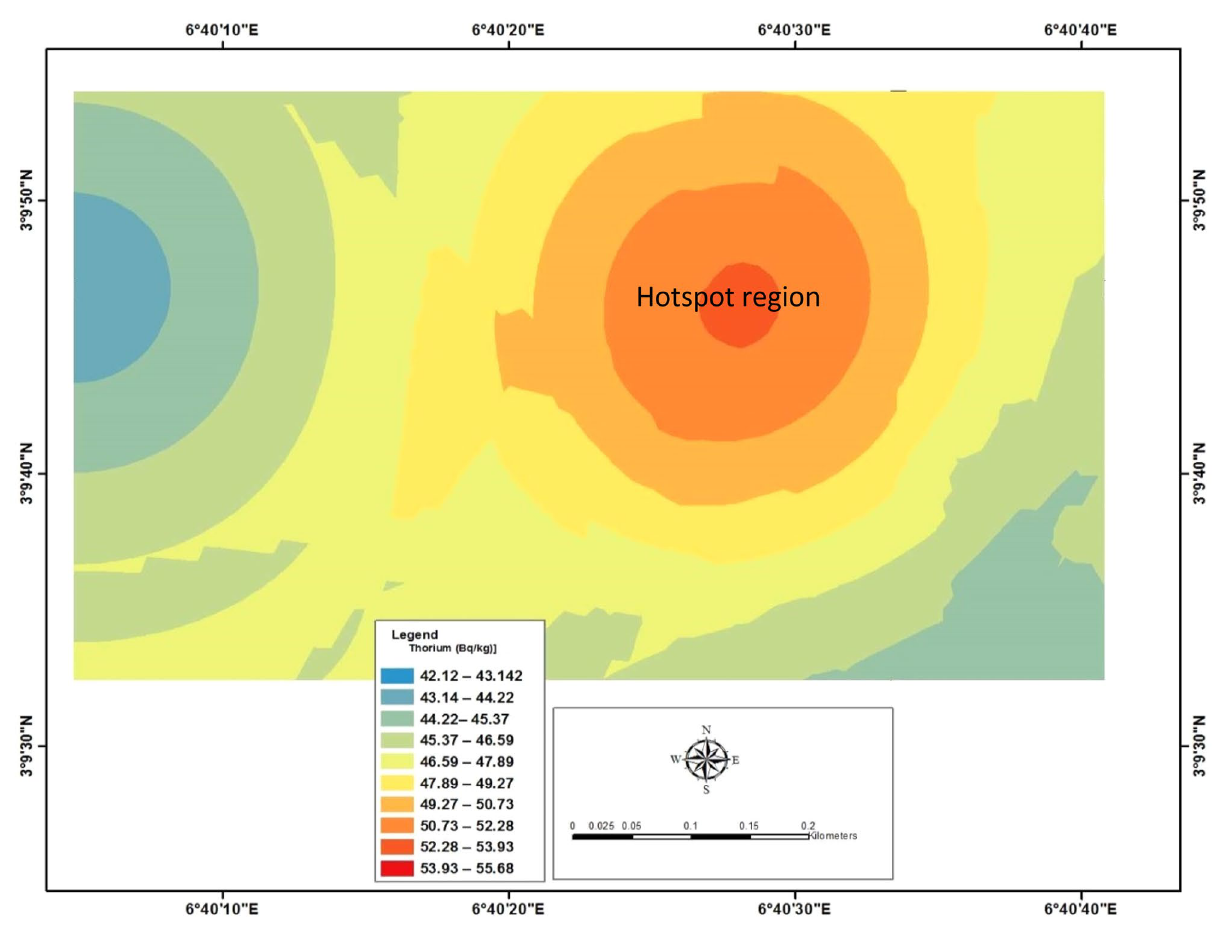
Figure 4. Showing the distribution pattern of Thorium-232 ( 232 Th) in the study